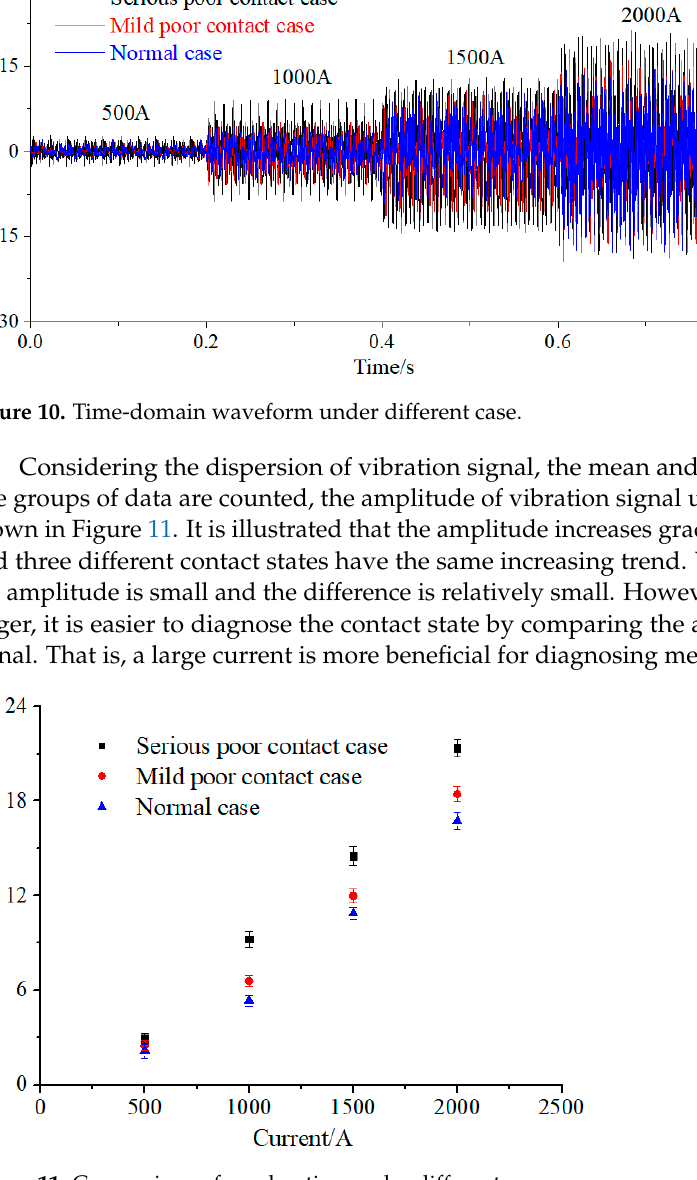
Figure 11. Comparison of acceleration under different cases.